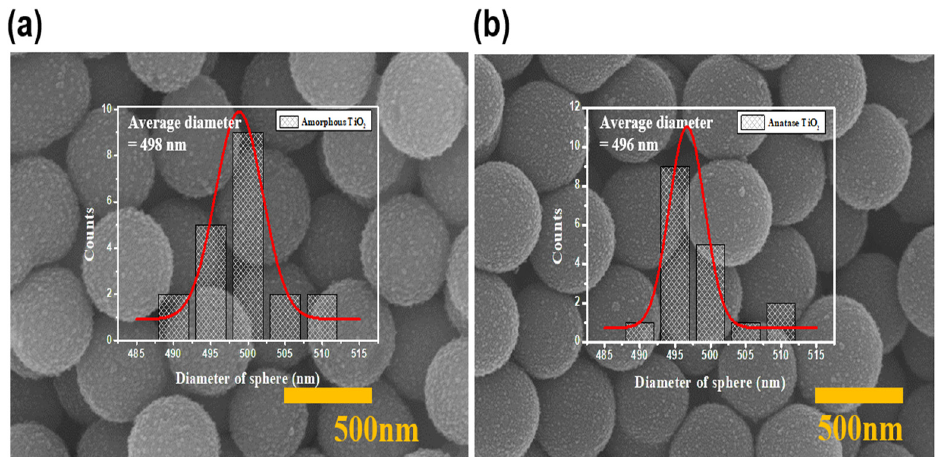
Figure 2. SEM images of ( a ) Am- and ( b ) An-TiO 2 NSs. The inset figure shows the size distributions of used TiO 2 NSs.